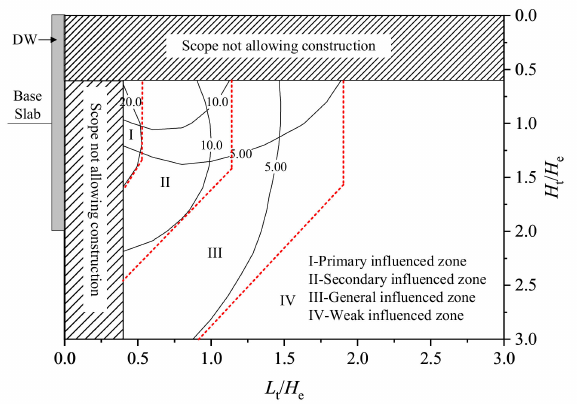
Figure 6. Influenced zones of deep excavation on adjacent tunnel displacement after